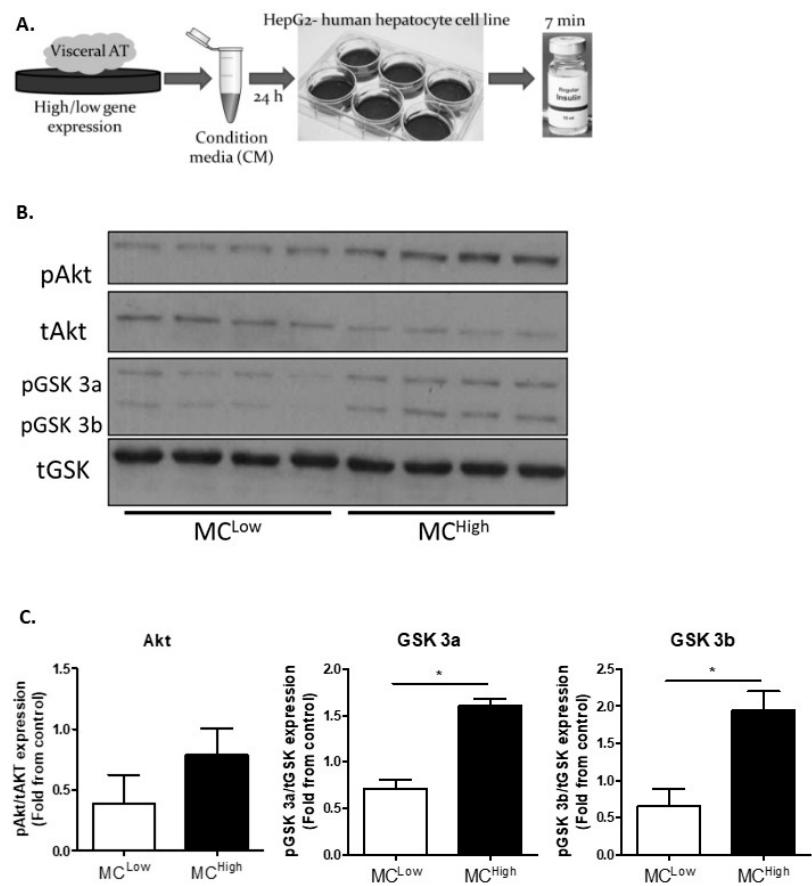
Figure 4. Insulin signaling in HepG2 cells after treatment with condition media from the VAT of obese MC low / high . ( A ) Schematic experimental design: VAT explants were incubated in media for 24 h for the